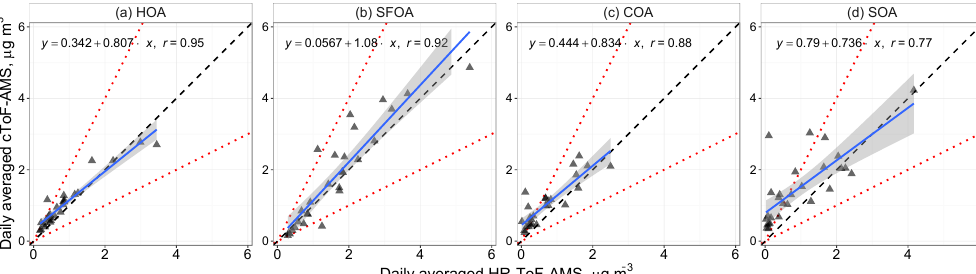
Figure 4. Scatter plots of PMF-derived OA component concentrations – (a) HOA, (b) SFOA, (c) COA, and (d) SOA – based on different AMS instruments at the London North Kensington site during the winter IOP. The dashed lines are the 2:1, 1:1, and 1:2